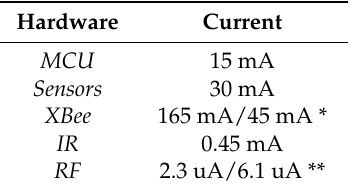
Table 3. Nominal current values for subunits within a sensing